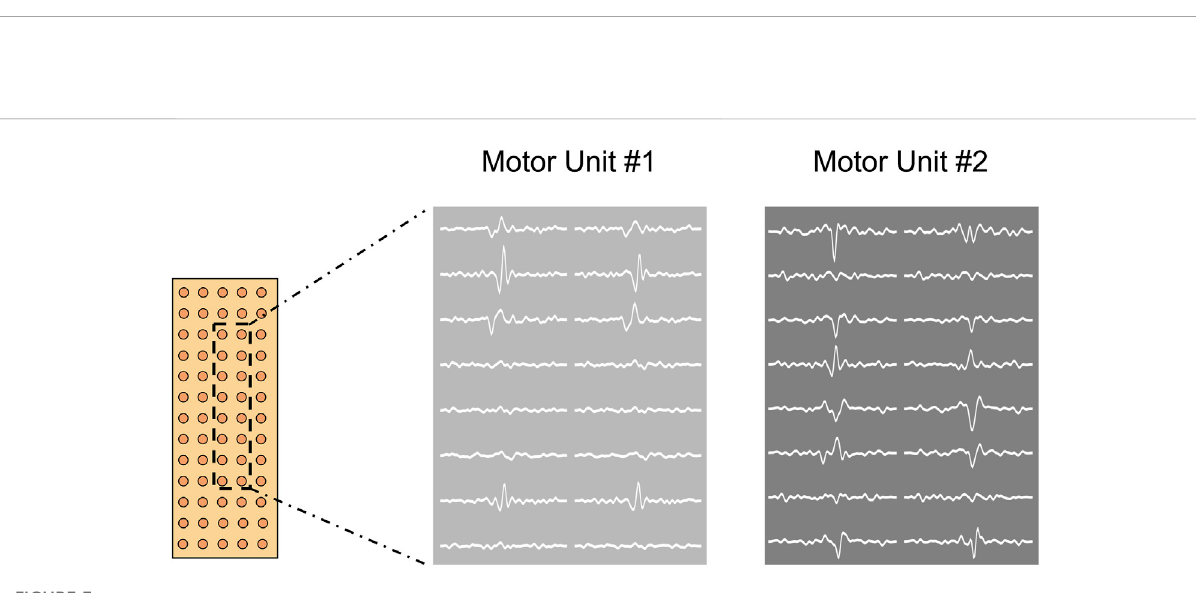
FIGURE 3 Graphical representation of a high-density EMG grid and signal. In this fi gure it is depicted an example of two different motor unit action potentials obtained from the decomposition process. Grids are made up of 64 electrodes (13 rows x 5